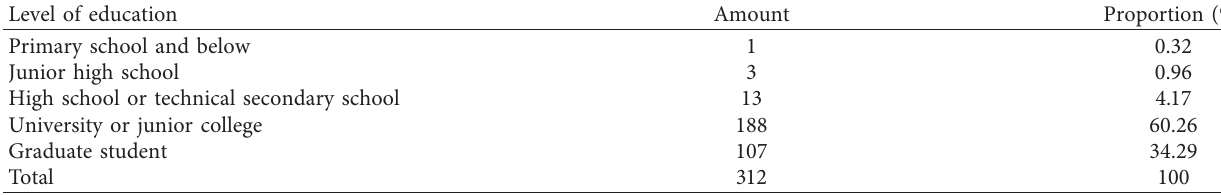
Table 3: Distribution of the respondents’ educational background.